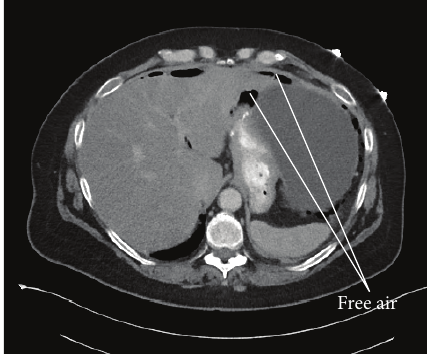
Figure 1: CT scan of abdomen showing moderate to large amount of intraperitoneal free air, likely representing bowel perforation.